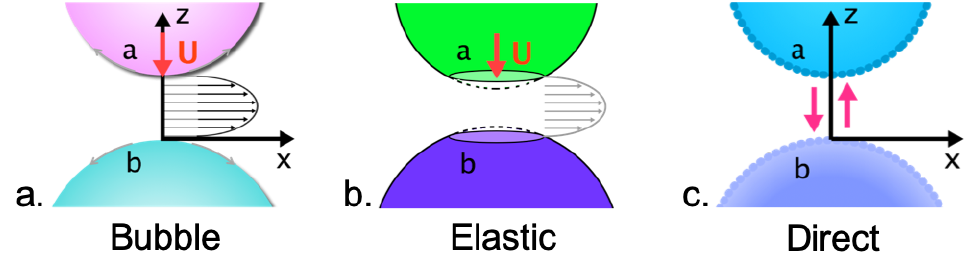
Figure 1. The bubble interaction is a combination of the Bubble Force, F Bubble , the Elastic Force, F Elastic , and the Direct Force F Direct